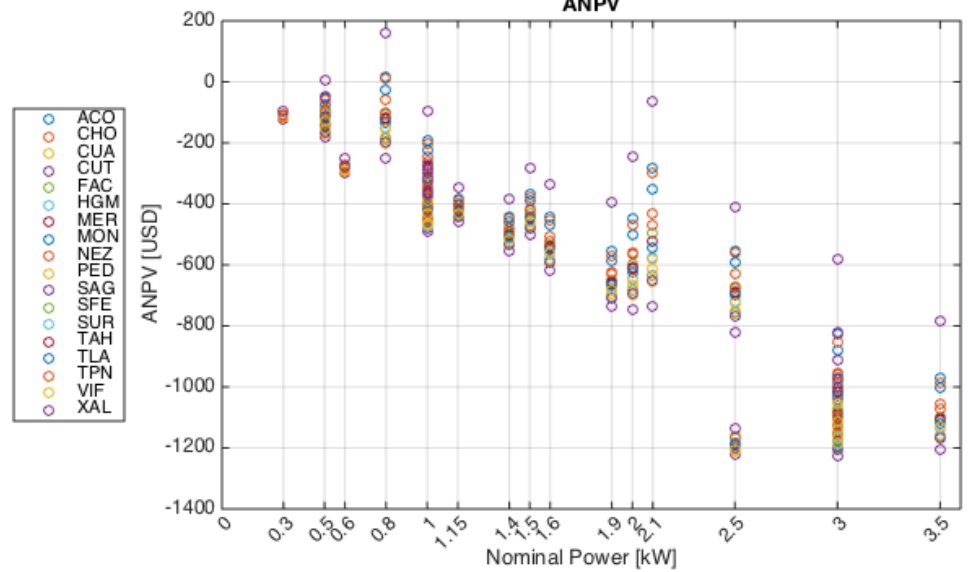
Figure 11. Turbines with equal nominal power are grouped and plotted under the corresponding values in such a way that individual ANPVs may not be observed in order to analyze the existence of a global tendency.